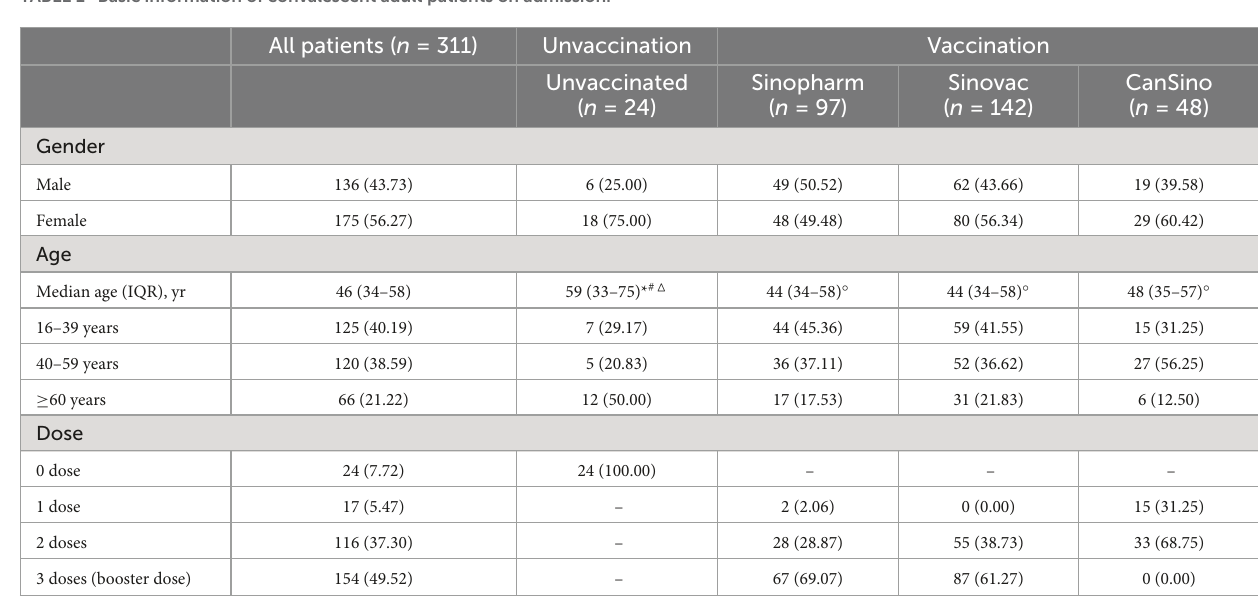
TABLE 1 Basic information of convalescent adult patients on